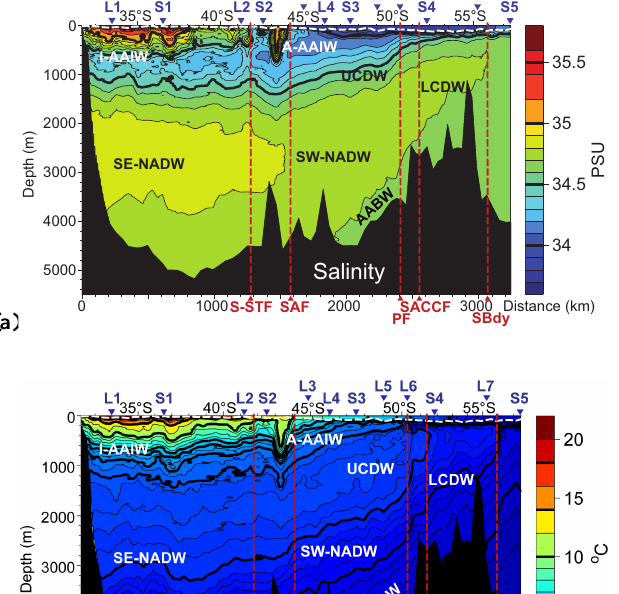
Fig. 3. Vertical section of (a) labile Fe(II) in nM and (b) %Fe(II)/DFe from the north (left) to the south (right) of the sec- tion. DFe data are from Chever et al.